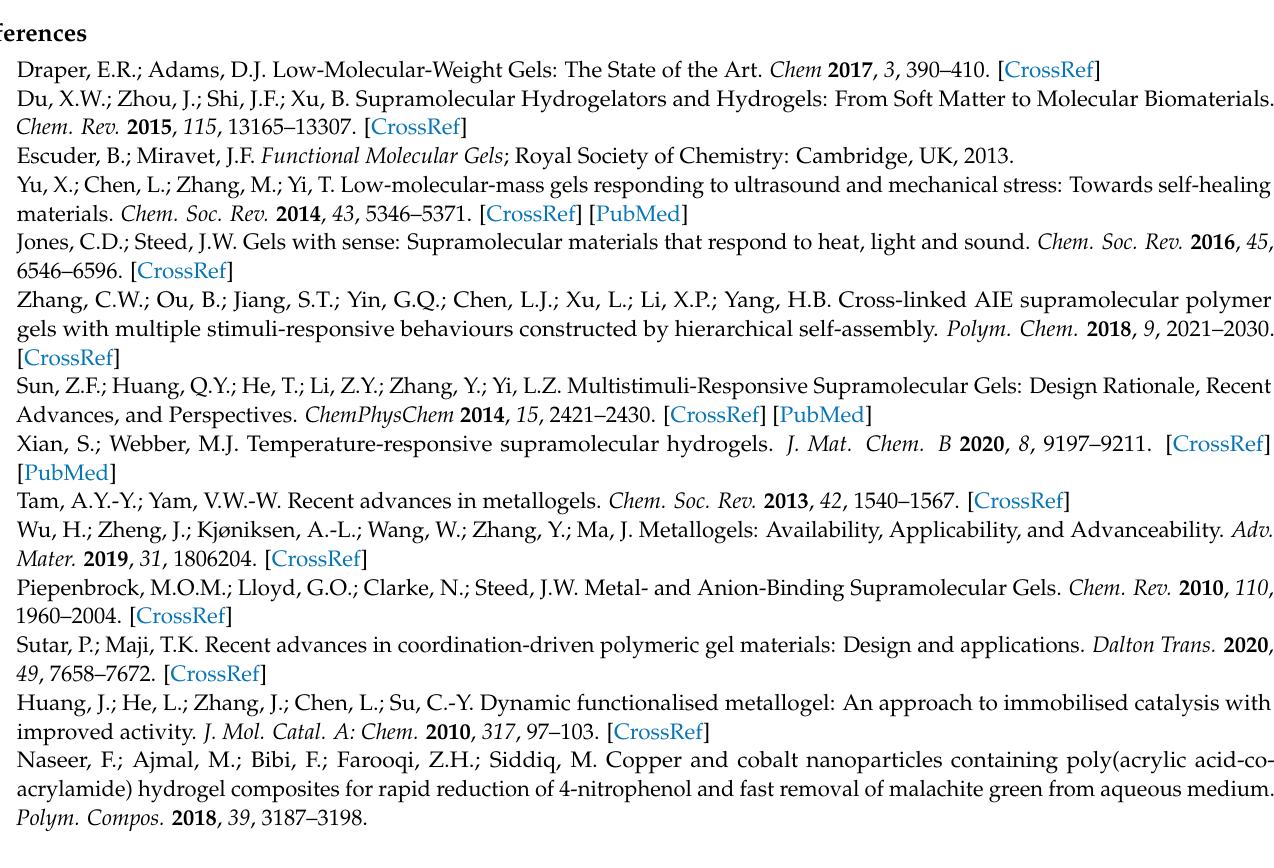
(dotted line), Figure S7: ATR-FTIR spectrum of 1 (solid line) and the lyophilized deprotonated sample (dotted line), Figure S8: Amplitude sweep experiment of the 1 -HCl gel, Figure S9: Picture of vials containing the hydrogels obtained with the different triggers, Figure S10: ATR-FTIR spectra of the monovalent cation induced hydrogels recorded on the lyophilized samples, Figure S11: ATR-FTIR spectra of divalent and trivalent cation induced hydrogels recorded on the lyophilized samples, Figure S12: CD-spectra of the monovalent cation induced hydrogels, Figures S13–S24: TEM images of the hydrogels, Figures S25 and S26: Amplitude sweep experiments of metal-induced hydrogels; Table S1: Average value of G (cid:48) and G” and the flow point, Figure S27: Colorimetric responses of the 1 -Cu 2+ gel to methylamine, diethylammine, and triethylammine, Figure S28: Photo of cuvettes containing hydrogels and adsorbed methylene blue, Figure S29: Absorption spectra of a 15 mg/L solution of methylene blue in the presence of 1 -HCl hydrogel, Figure S30: Absorption spectra of a 15 mg/L solution of methylene blue in the presence of 1 -Na+ hydrogel, Figure S31: Absorption spectra of a 15 mg/L solution of methylene blue in the presence of 1 -Zn 2+ hydrogel, Figure S32: Absorption spectra of a 10 mg/L solution of methylene blue in the presence of 1 -Zn 2+ xerogel, Figure S33: Absorption spectra of a 10 mg/L solution of methyl orange in the presence of 1 -Zn 2+ xerogel, Figure S34: Absorption spectra of a mixture of methylene blue and methyl orange, 5 mg/mL, in the presence of 1 -Zn 2+